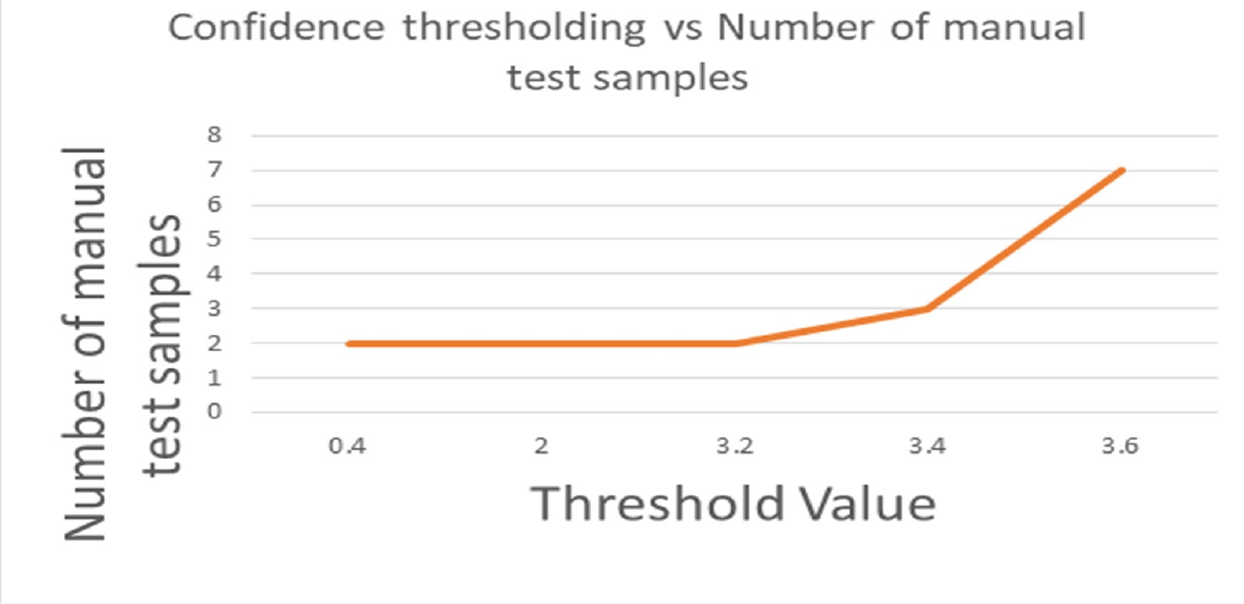
Figure 19. Confidence thresholding vs. Number of manual test samples by using Yolov4 under the balanced data set. In summary, when a deep learning object detection integrated with majority voting algorithms is used for identifying the TNR sterilization operations through calculation results (unbalanced dataset and special balanced dataset), the trained Yolov4 mAP reaches 91.99%. The result integrates majority voting algorithms’ accuracy reaching 85% with an unbalanced dataset. So, it can save more than 85% of manual detection time. Using the best accuracy of the model to evaluate the TNR sterilization can undoubtedly save manual detection time. For object detection with a small number of samples and small